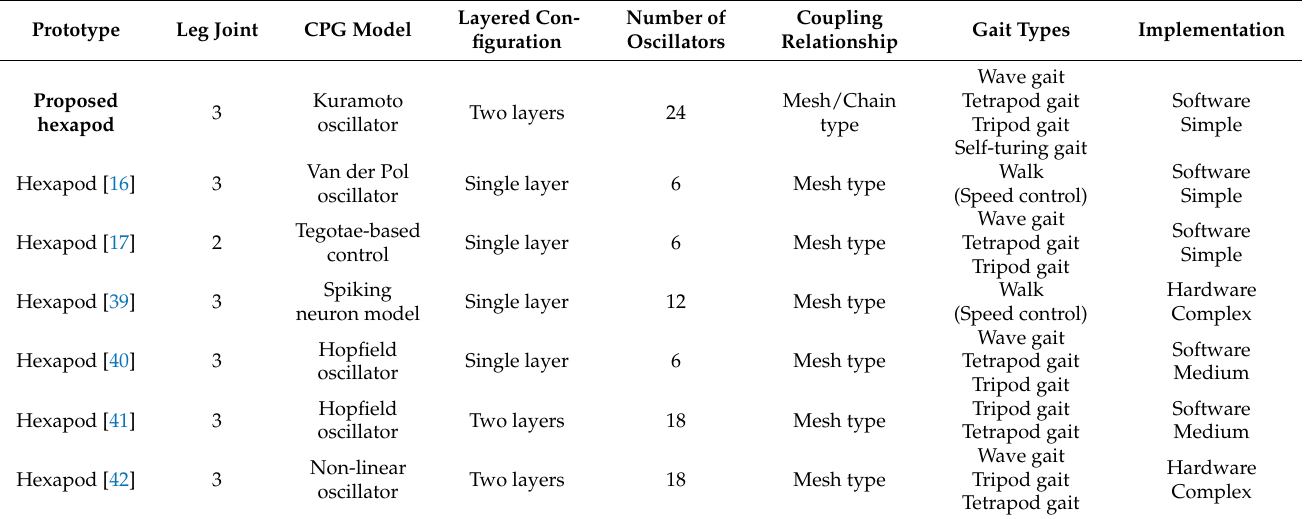
Table 1. The comparisons of the proposed CPG with other CPG-based biomimetic hexapod